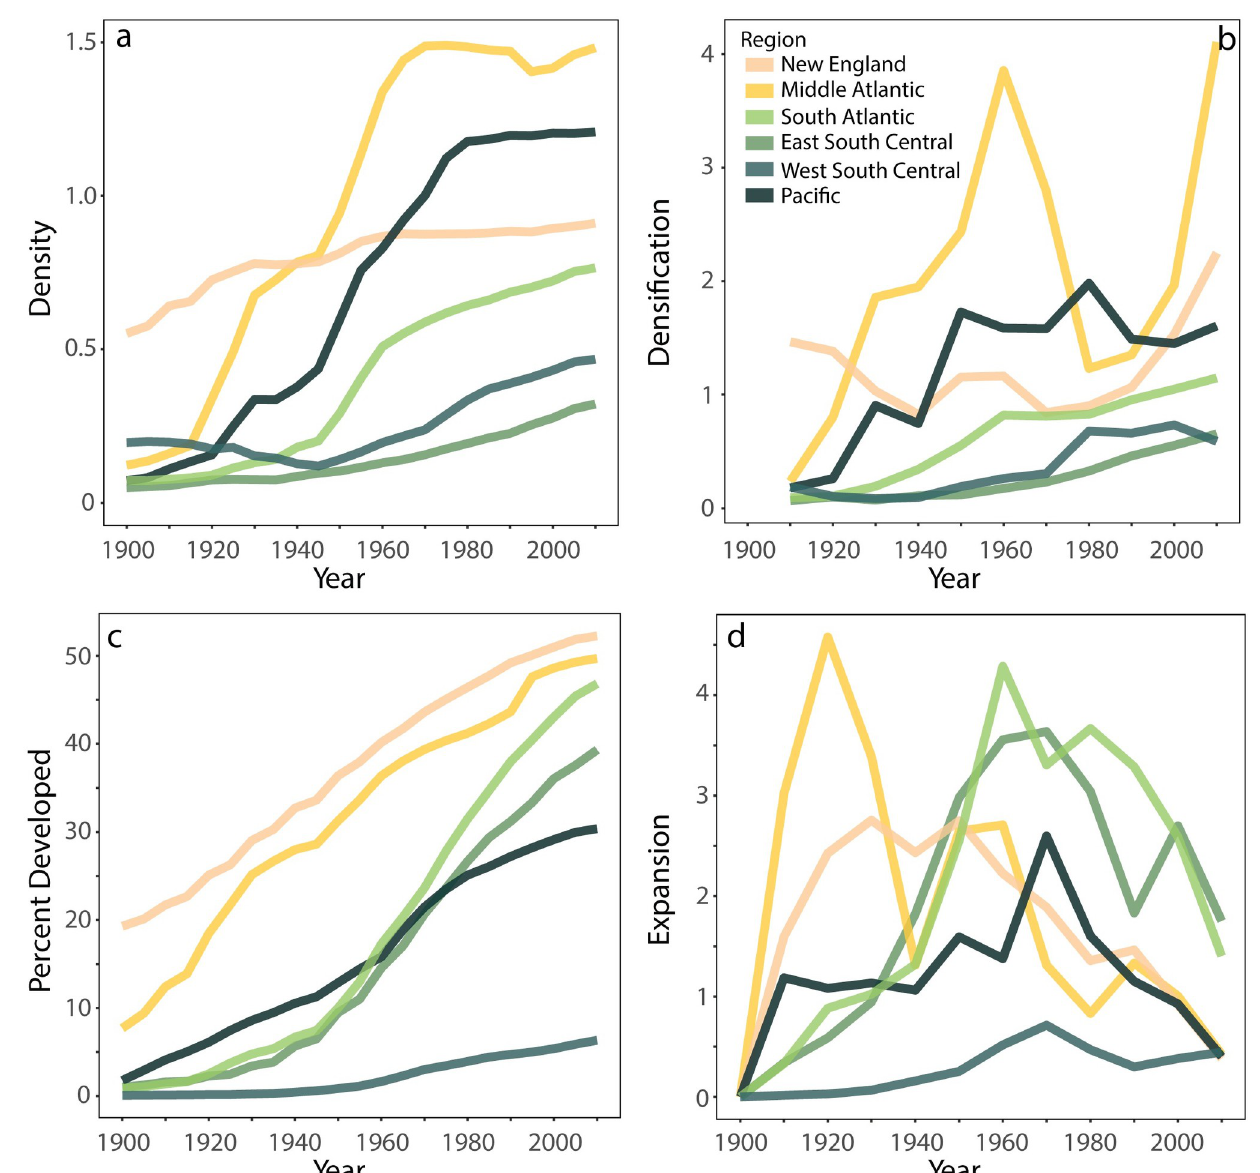
Fig 4. Regional trends in the 6 feet SLR zone tell a varied story about the timing and intensity of historical coastal development. Built environment characteristics are based on structure density (structures per developed grid cell); a); densification (structures added relative to expansion; values greater than 1 mean that density is increasing faster than the addition of developed land grid cells); b); proportion of the SLR zone developed (proportion of grid cells developed within the unit of measurement); c); and expansion (increase in developed grid cells); d). Colors denote coastal MSAs aggregated to Census Divisions. Densification (b) and expansion (d) were calculated over 10-year time